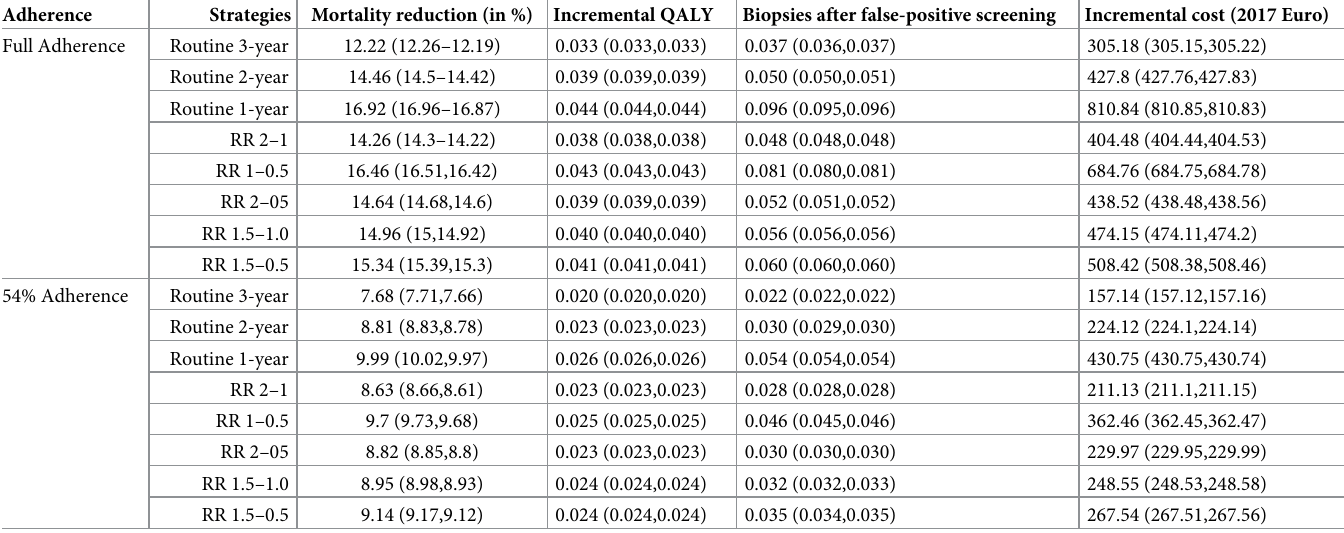
Table 2. Outcomes and costs as increments per strategy vs. no screening, mean (confidence interval) per woman. Adherence